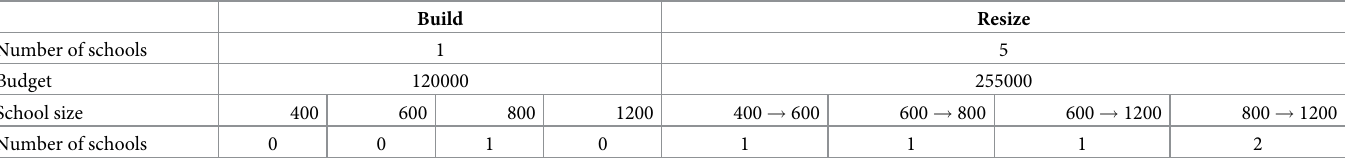
Table 4. Updates in the 2020-2025 period.